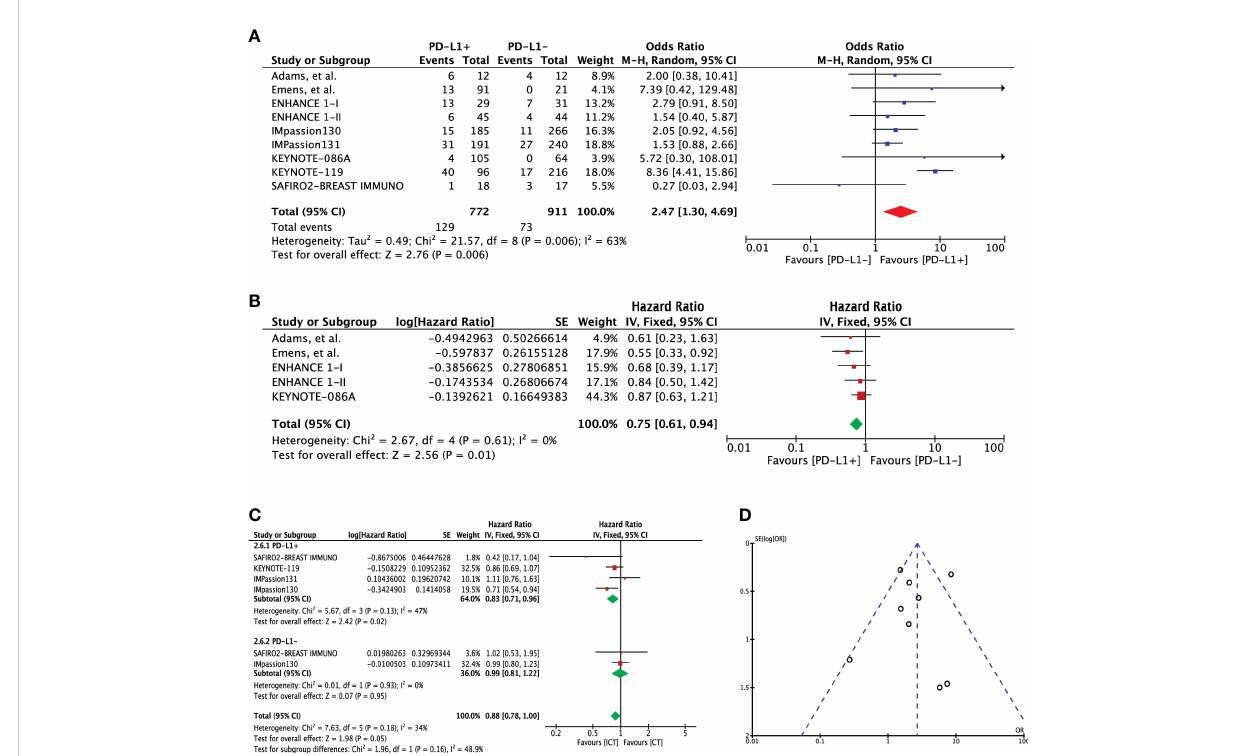
FIGURE 4 (A) Comparison of 2-year overall survival (OS) in advanced metastatic TNBC (mTNBC) patients treated with PD-1 checkpoint inhibition therapy based on PD-L1 expression. (B) Comparison of overall survival (OS) in advanced metastatic TNBC (mTNBC) patients treated with PD-1 checkpoint inhibition therapy based on PD-L1 expression. (C) Comparison of overall survival (OS) in PD-L1+ and PD-L1- metastatic TNBC (mTNBC) patients between patients receiving PD-1 checkpoint inhibitors plus chemotherapy (ICT) and CT alone. (D) Funnel plot of publication bias assessment in 2-year overall survival (OS) analysis.